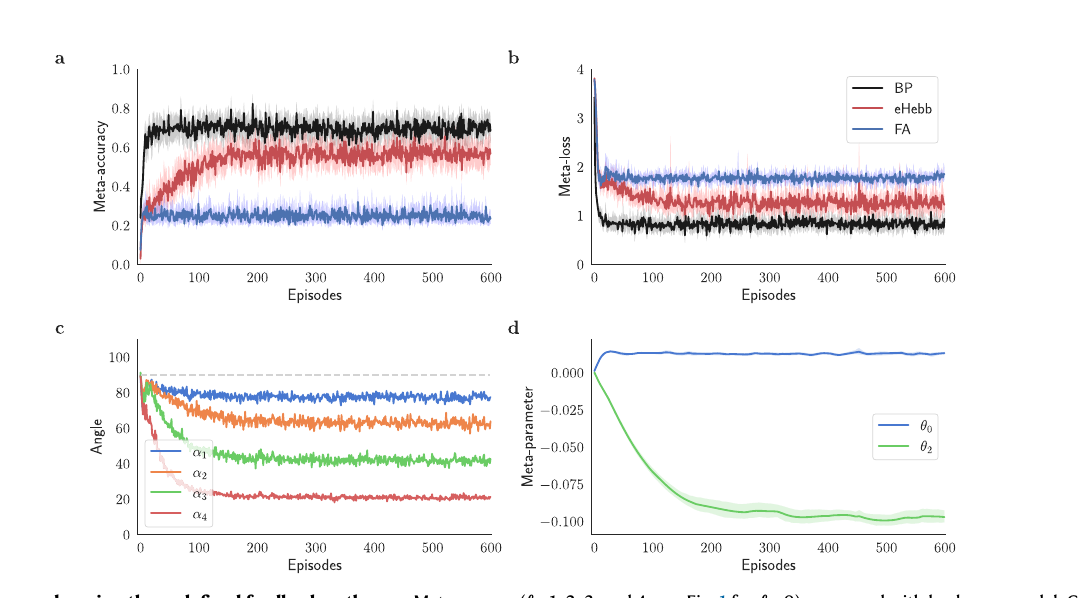
( ℓ =1, 2, 3, and 4; see Fig. 1 for ℓ =0) compared with backprop model. Comparing panels a and c indicates that F eHebb improves the model ’ s performance by ren- dering the modulatory signals to be more backprop-like. d Convergence of the plasticity coef fi cients Θ ={ θ 0 , θ 2 } using the meta-learning model (Alg. 1). The meta- optimizer starts converging after 200